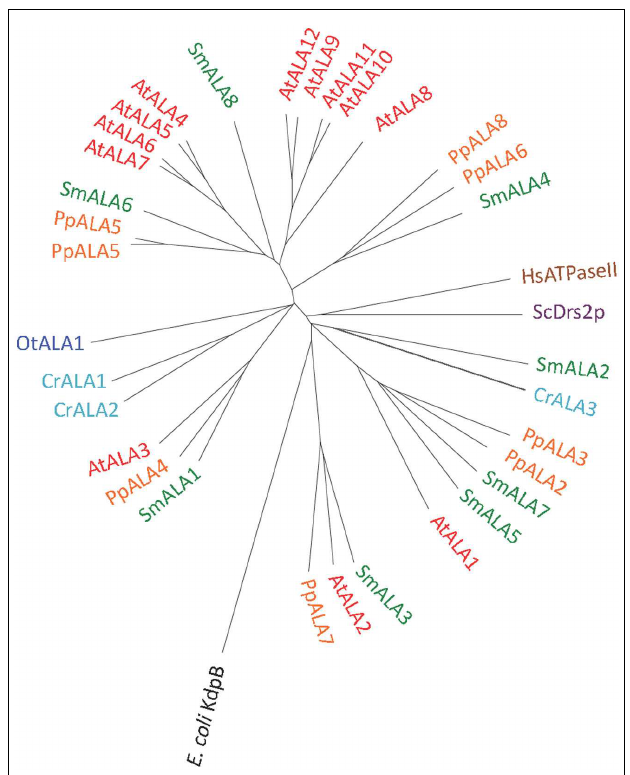
FIGURE 12 | Phylogenetic tree of P4ATPases (lipid flippases). Accession numbers for sequences are given in Table 2 . For comparison, the following outliers were included: A bacterial P1A ATPase E. coli KdpB (P03960), the S. cerevisiae pump ScDrs2p (P39524), and the H. sapiens pump HsATPaseII (ATP8A1; Q9Y2Q0).